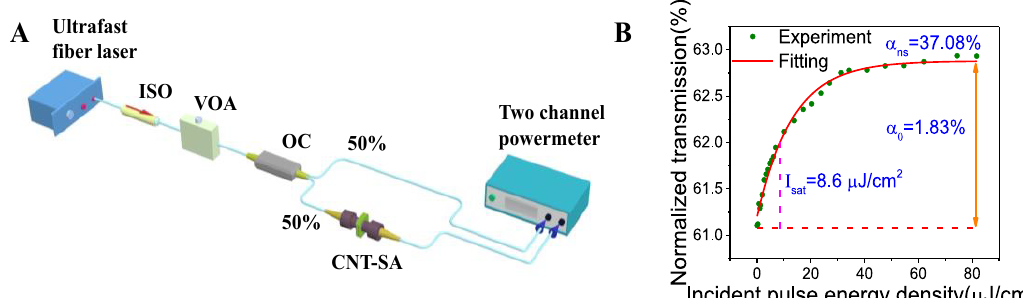
Figure 2: Power-dependent transmission measurement. (A) Experiment setup. ISO, isolator; VOA, variable optical attenuator; OC, output coupler. (B) Measured results from CNT – polyvinyl alcohol (PVA)